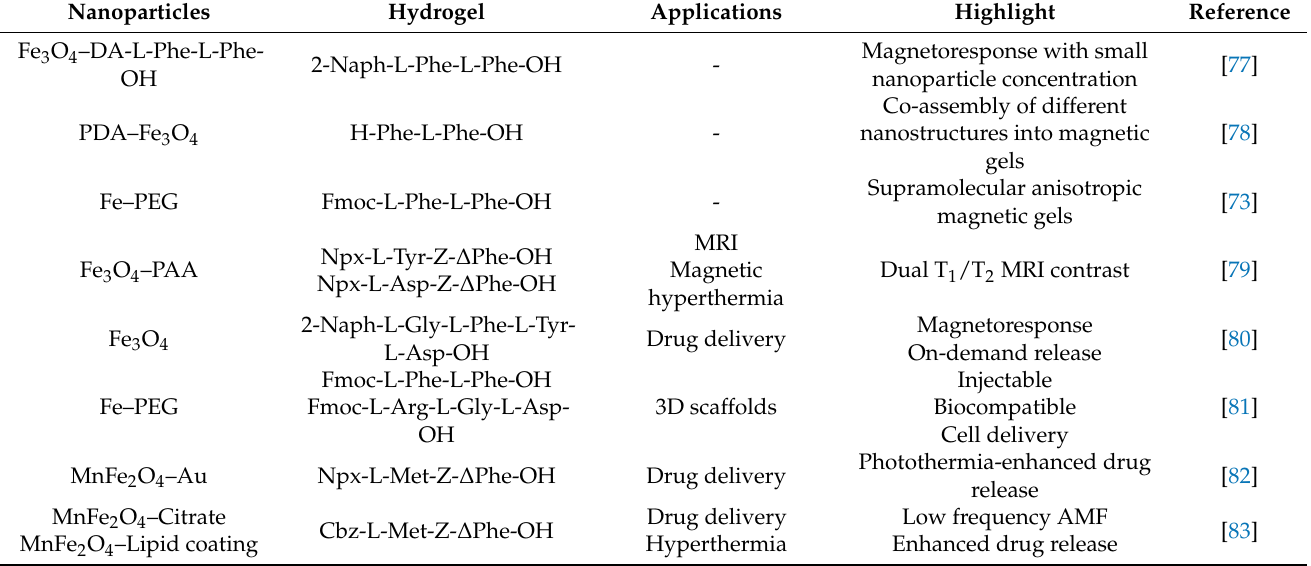
Table 2. Summary of advancements with peptide LMWG-based magnetic hydrogels. 2-Naph: 2- (Naphthalen-6-yl) acetic acid; DA: Dopamine; Phe: Phenylalanine; PDA: polydopamine; PEG: poly (ethylene glycol); PAA: Poly (acrylic acid); Npx: Naproxen; Asp: Aspartate; Tyr: Tyrosine; ∆